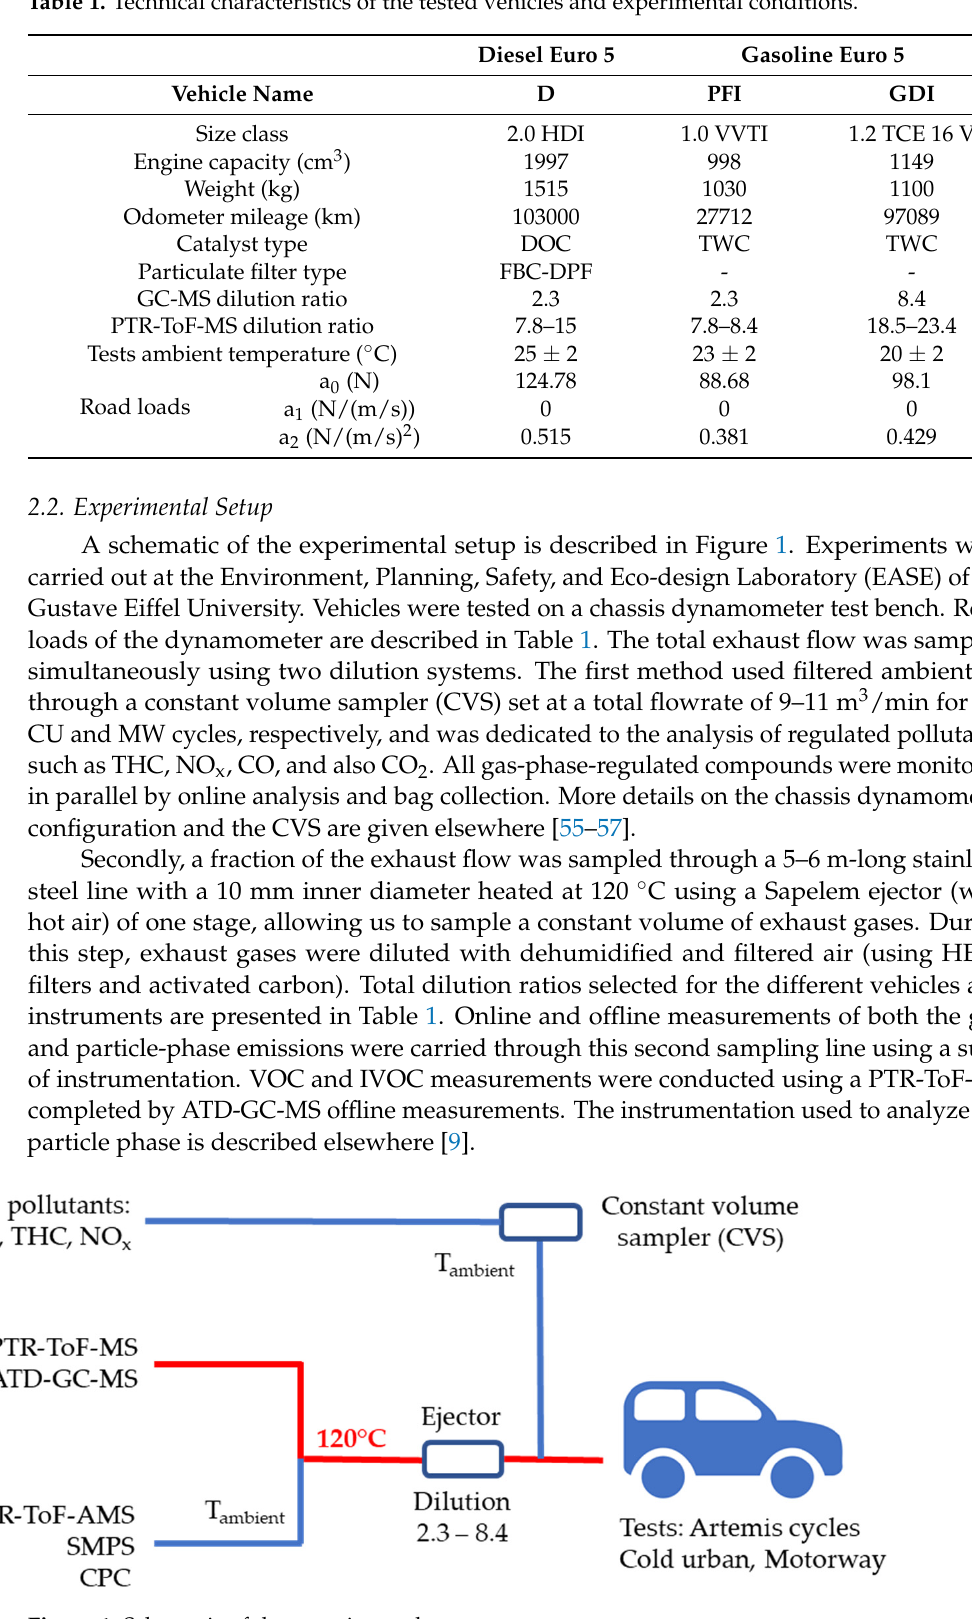
Figure 1. Schematic of the experimental setup.